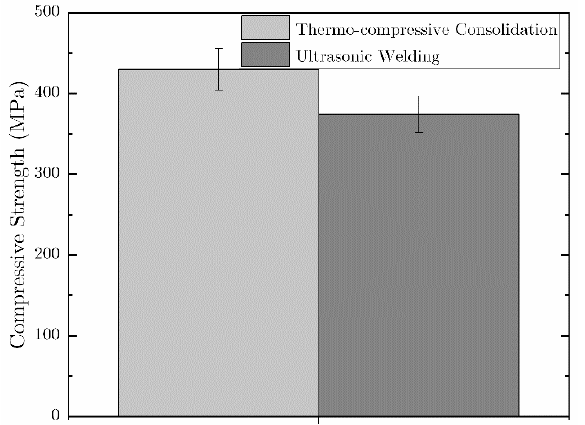
Figure 16. Plots of the CFRPs’ compressive strength measured for thermo-compressive consolidation and ultrasonic welding.